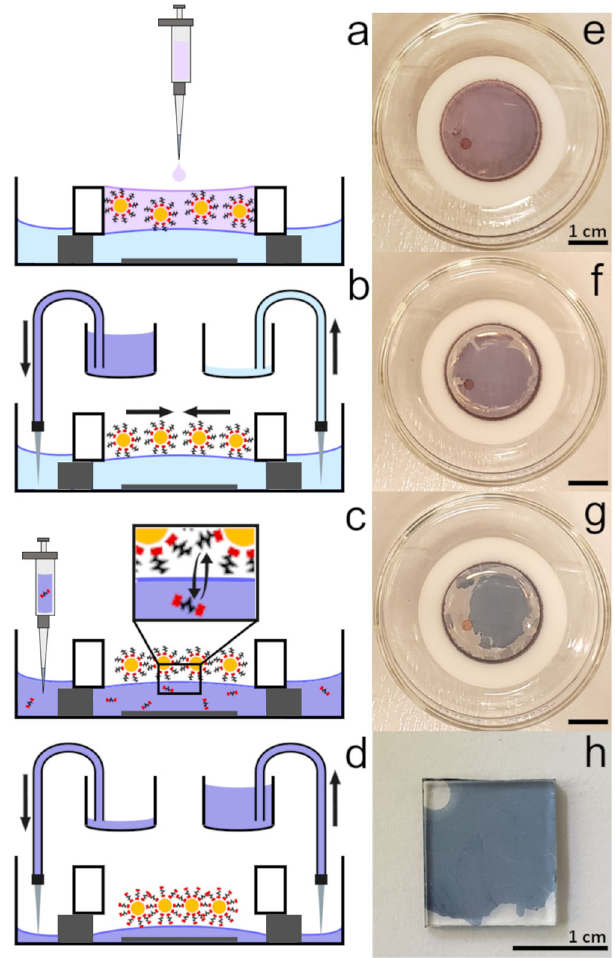
Fig. 1 Illustration of the method used to fabricate X-NS. a Size-selected Au NPs are dispersed in hexane and drop cast on the water surface inside the Te fl on ring (~2.51 cm inner diameter, supported by two 1 mm thick glass slides on each side, and positioned in a glass well with ∼ 6 cm diameter and ∼ 1.5 cm height). The Au NPs form a monolayer at the air – water interface as the hexane evaporates. b Methanol is pumped in and methanol/water is pumped out at ∼ 1.2 mL min − 1 using two peristaltic pumps. c A molecular cross-linker is introduced into the methanol subphase. d The methanol molecular cross-linker solution is exchanged for neat methanol using two peristaltic pumps and fi nally the methanol subphase is drained to deposit the X-NS upon a substrate. e – h Photographs of the NP fi lms formed in steps ( a – d ), respectively using 6.84 ± 0.61 nm Au NPs and butanedithiol cross-linker. All scale bars correspond to 1